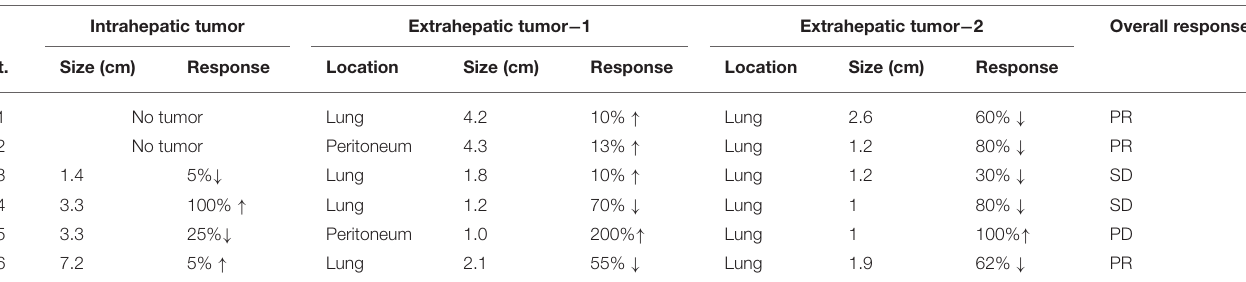
TABLE 3 | Patients with heterogeneous responses to nivolumab.